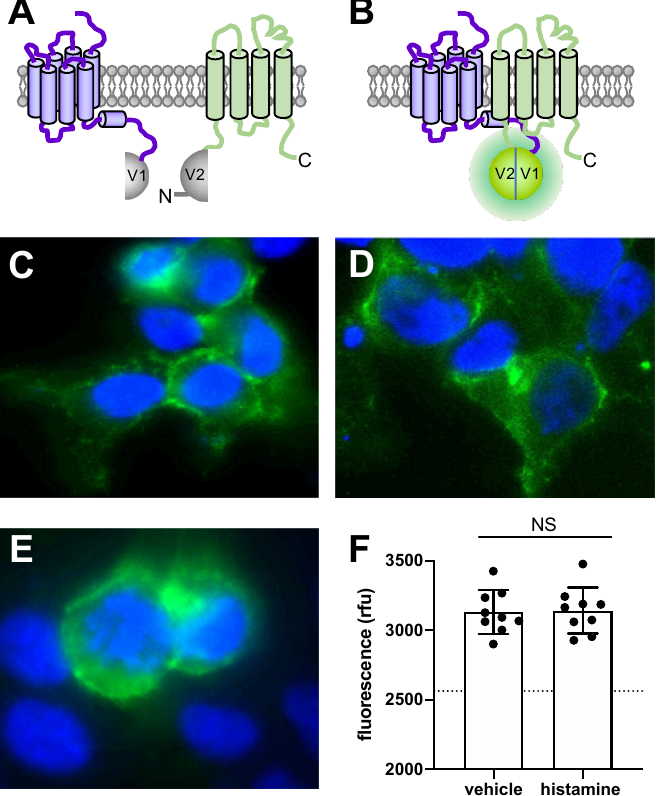
Figure 4. Detection of close proximity between H 4 R and TSPAN4 at the surface of HEK293T cells using bimolecular fluorescence complementation. ( A , B ) In-frame fusion of the nonfluorescent complementary mVenus fragments V1 and V2 to the intracellular C-terminal tail of H 4 R and N-terminal tail of TSPAN4 allows functional reconstitution of mVenus that is driven by the close proximity between H 4 R and TSPAN4. ( C , E ) HEK293T cells transiently co-transfected with H 4 R-V1 and V2-TSPAN4. Two days post-transfection, the cells were observed under microscope upon stimulation with vehicle ( C ) or 10 µ M histamine ( E ). Interaction between H 4 R-V1 and V2-TSPAN4 reconstitutes mVenus (green), nuclei are stained with 4’6-diamidino-2-phenylindole (blue). ( D ) Image of cells two days after transient transfection with mVenus-TSPAN4. Representative images ( C – E ) are shown from three independent experiment performed in triplicate. ( F ) Fluorescence intensity of the reconstituted mVenus upon stimulation with vehicle or 10 µ M histamine was measured by plate reader at 497-15 excitation and 540-20 emission. Dotted line represents the background fluorescence in mock transfected cells. Data are displayed as mean ± SD from 3 independent experiments performed in triplicate. Statistical difference was analyzed using Student’s t -test. NS = no significant